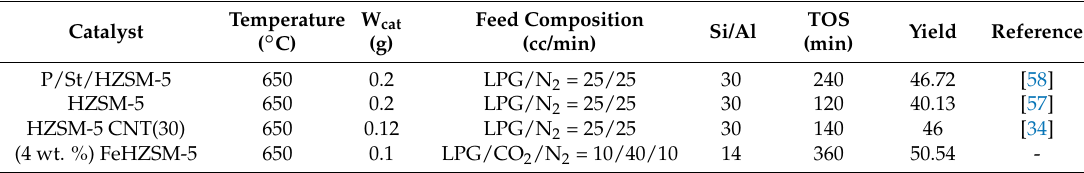
Table 7. Comparison of catalyst activity with previous